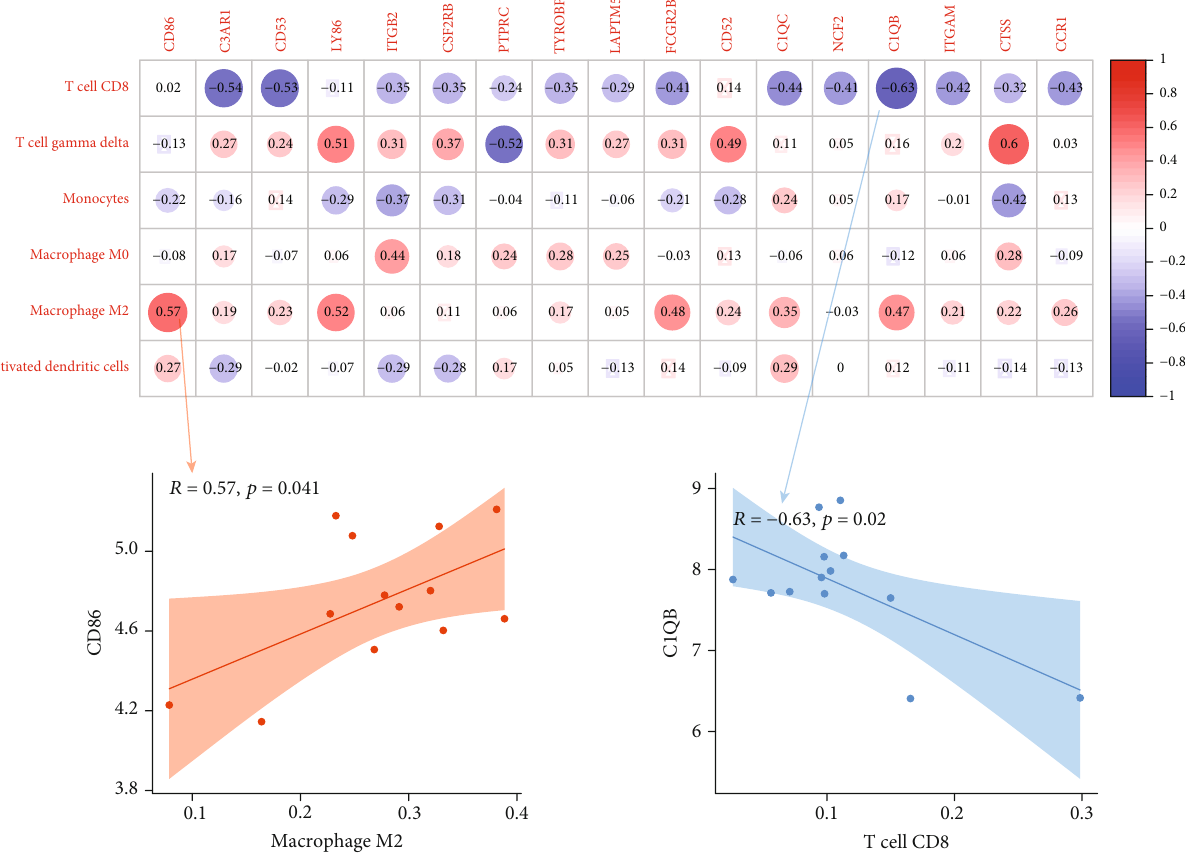
Figure 4: (a) Correlation between gene expressions and the relative percentages of immune cells in the EA group. (b) Scatterplots illustrate the exact relationship between the CD86 expression and the relative proportion of macrophage M2 ( R = 0 : 57 , p = 0 : 041 ) and the correlation between the C1QB expression and the relative proportion of T cell CD8 ( R = − 0 : 63 , p = 0 : 02 ). Gray-shaded areas in scatterplots represent the standard errors of the regression lines. R : correlation coe ffi